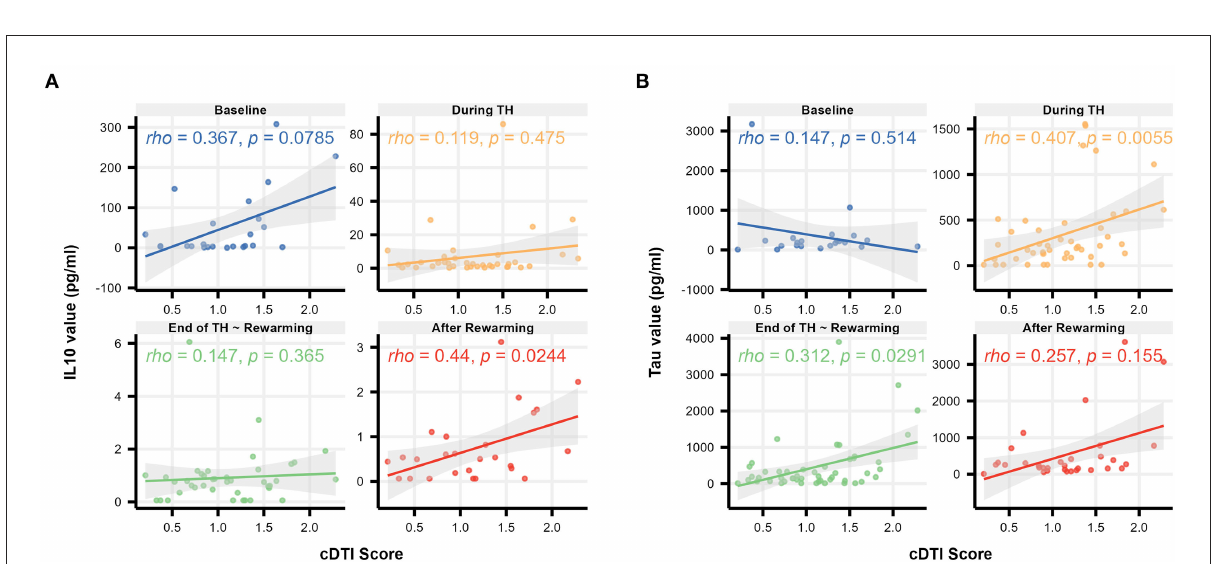
FIGURE6 Scatterplots illustrating the relationship between the cDTI score and biomarker values [ (A) : IL-10 and (B) : tau] over time (baseline, during TH, end of TH/rewarming, and after rewarming). Solid lines with gray areas indicate the regression lines with 95% confidence intervals, and Spearman’s correlation coefficients/ p -values are shown in the upper left corner of each